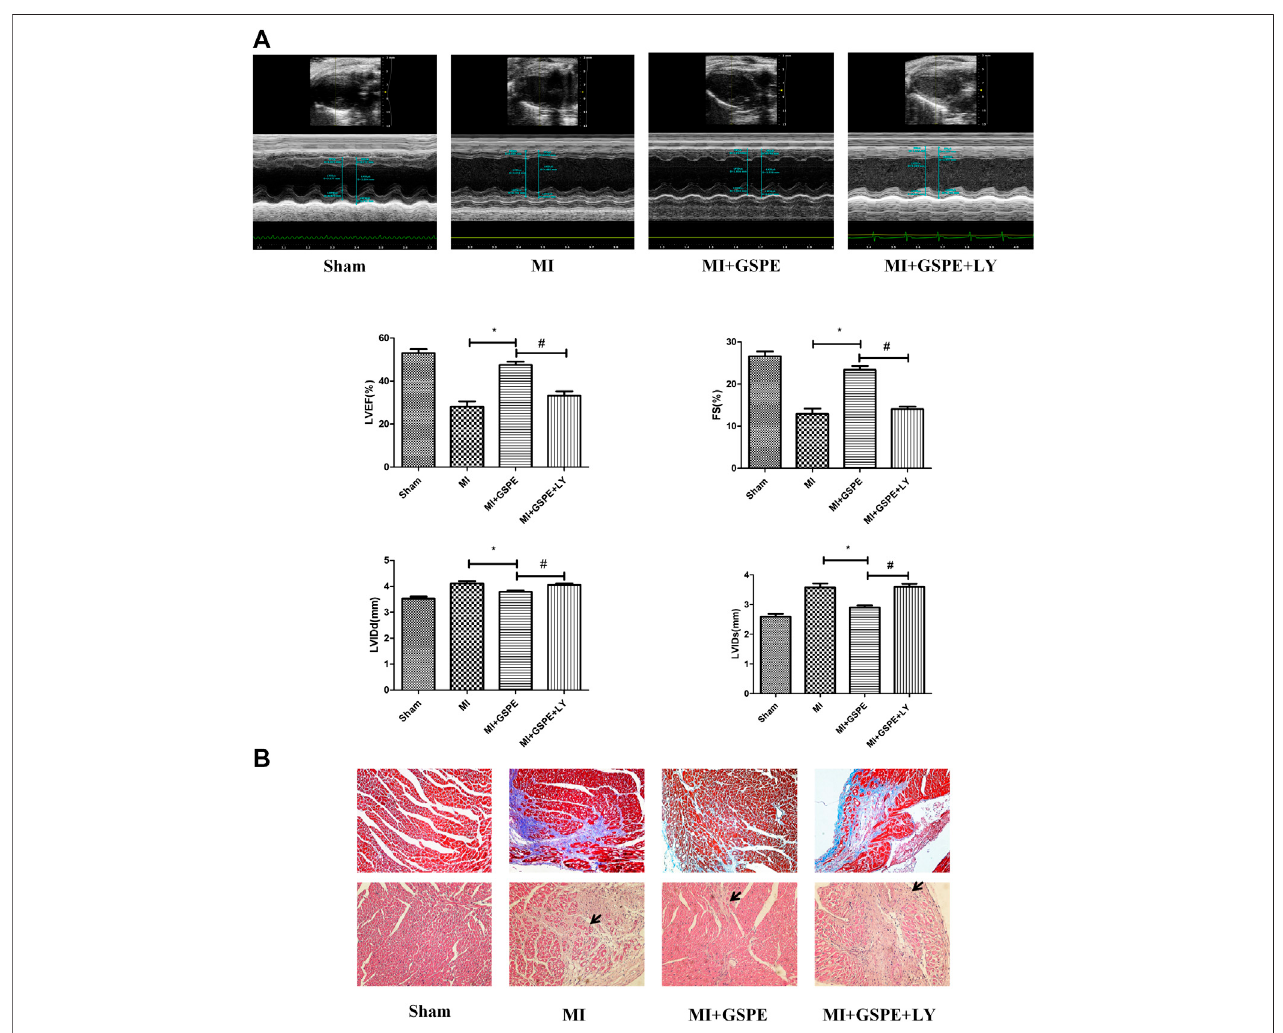
FIGURE 4 | Inhibition of the PI3K/AKT pathway reversed the protective effect of GSPE on cardiac function in vivo. (A) Representative M-mode echocardiographic images in short axis from each group, the relative indicatiors included are LVEF(%), FS(%), LVIDd(mm) and LVIDs(mm). (B) Pathological changes in HE-staining and Masson staining of cardiac section. The in fl ammatory cells in HE staining have been marked with arrows. Data analyzed are mean SD. *Signi fi cant difference compared with the MI group, p < 0.05; #signi fi cant difference compared with the MI + GSPE group, p < 0.05. n (cid:2) 3 per group.